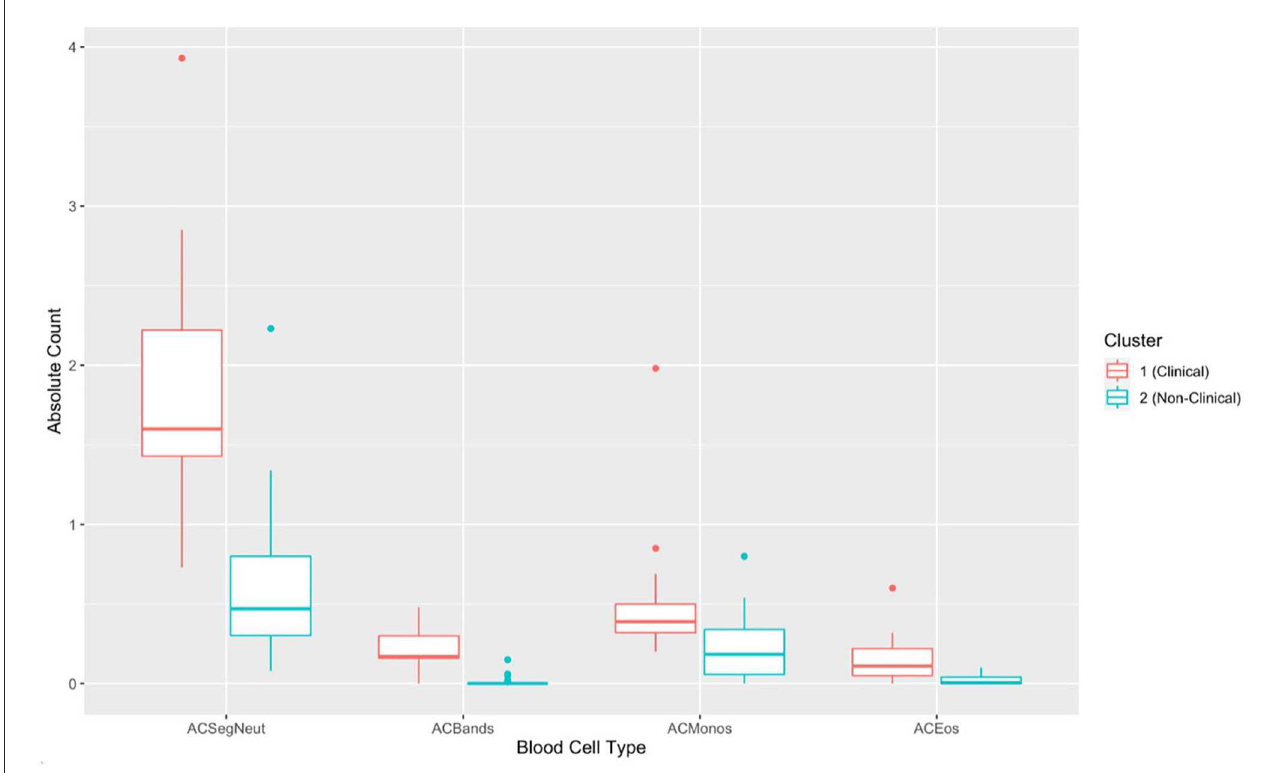
FIGURE8 Boxplots comparing each complete blood count variable for cluster 1 ( Batrachochytrium salamandrivorans ( Bsal ) infected, clinically diseased Taricha granulosa ) in red and cluster 2 (controls and Bsal -infected, non-clinically diseased T. granulosa ) in blue. Each box represents the interquartile range (IQR), the horizontal line within each box represents the median, vertical lines represent the 1.5 * IQR, and dots represent outliers. ACSegNeuts, Absolute count of segmented neutrophils; ACBands, absolute count of band neutrophils; ACMonos, absolute count of monocytes; ACEos, absolute count of